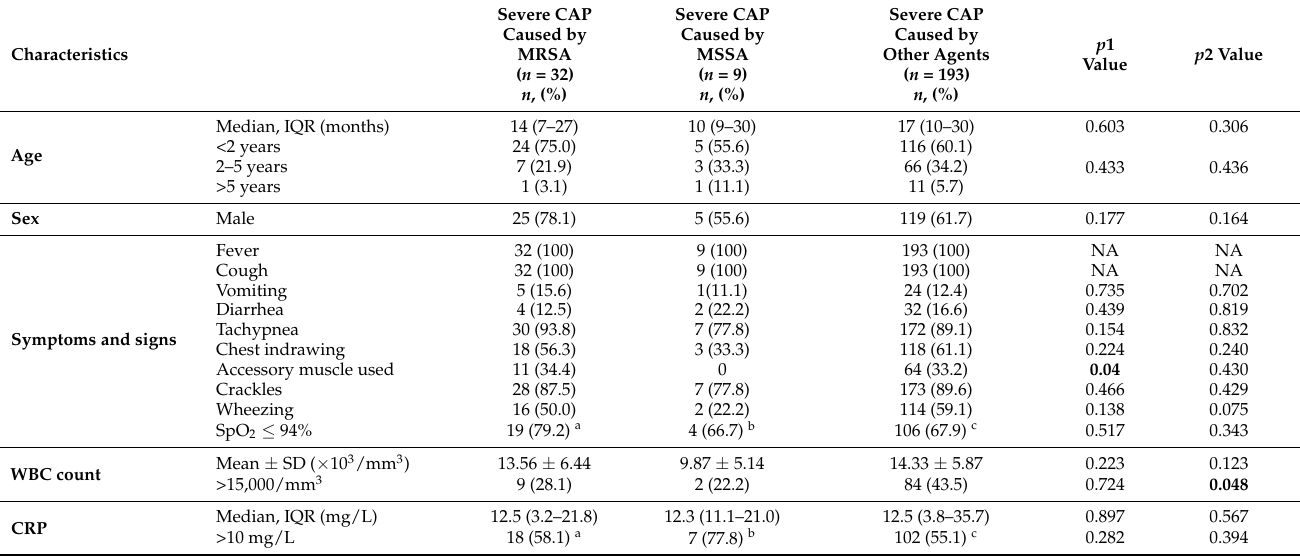
Table 1. Demographic, clinical, and subclinical